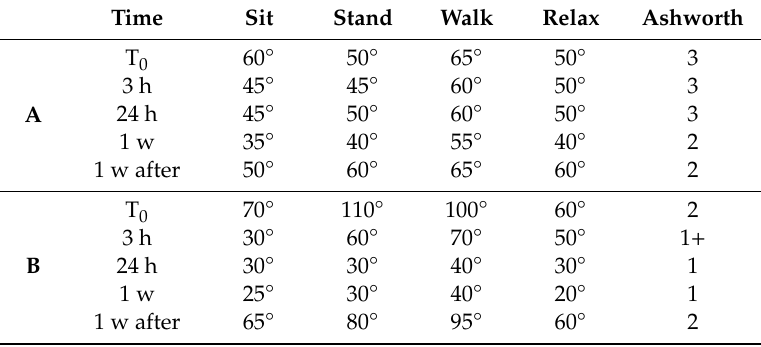
Table 1. Clinical follow-up: ROM and spasticity (without EDGES)